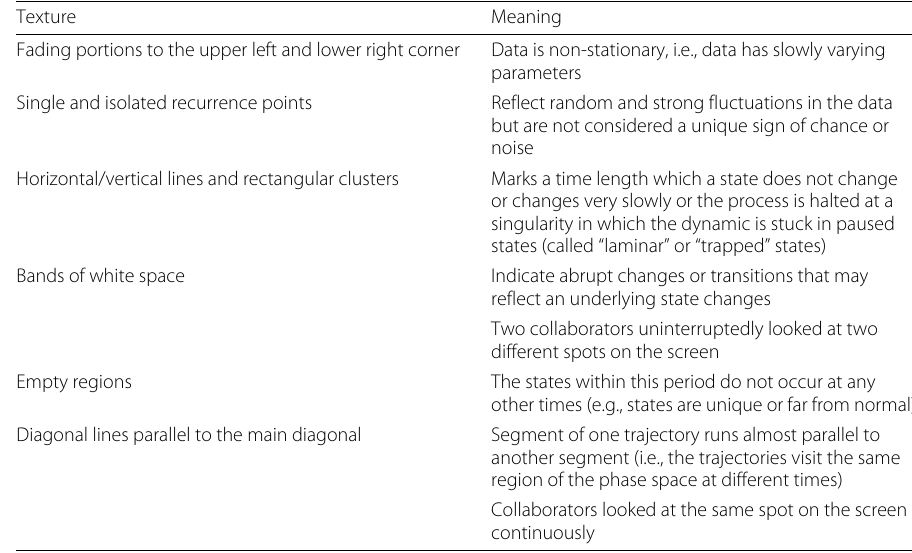
Fig. 2 An example of a cross-recurrence plot these fixations occurred. The fixations here are considered recurrent based on a given threshold since at these times the fixation points are about in the same location on the stimulus. These recurrent fixations are indicated by the pixelated regions enclosed in a red circle on the CRP in Fig. 2.